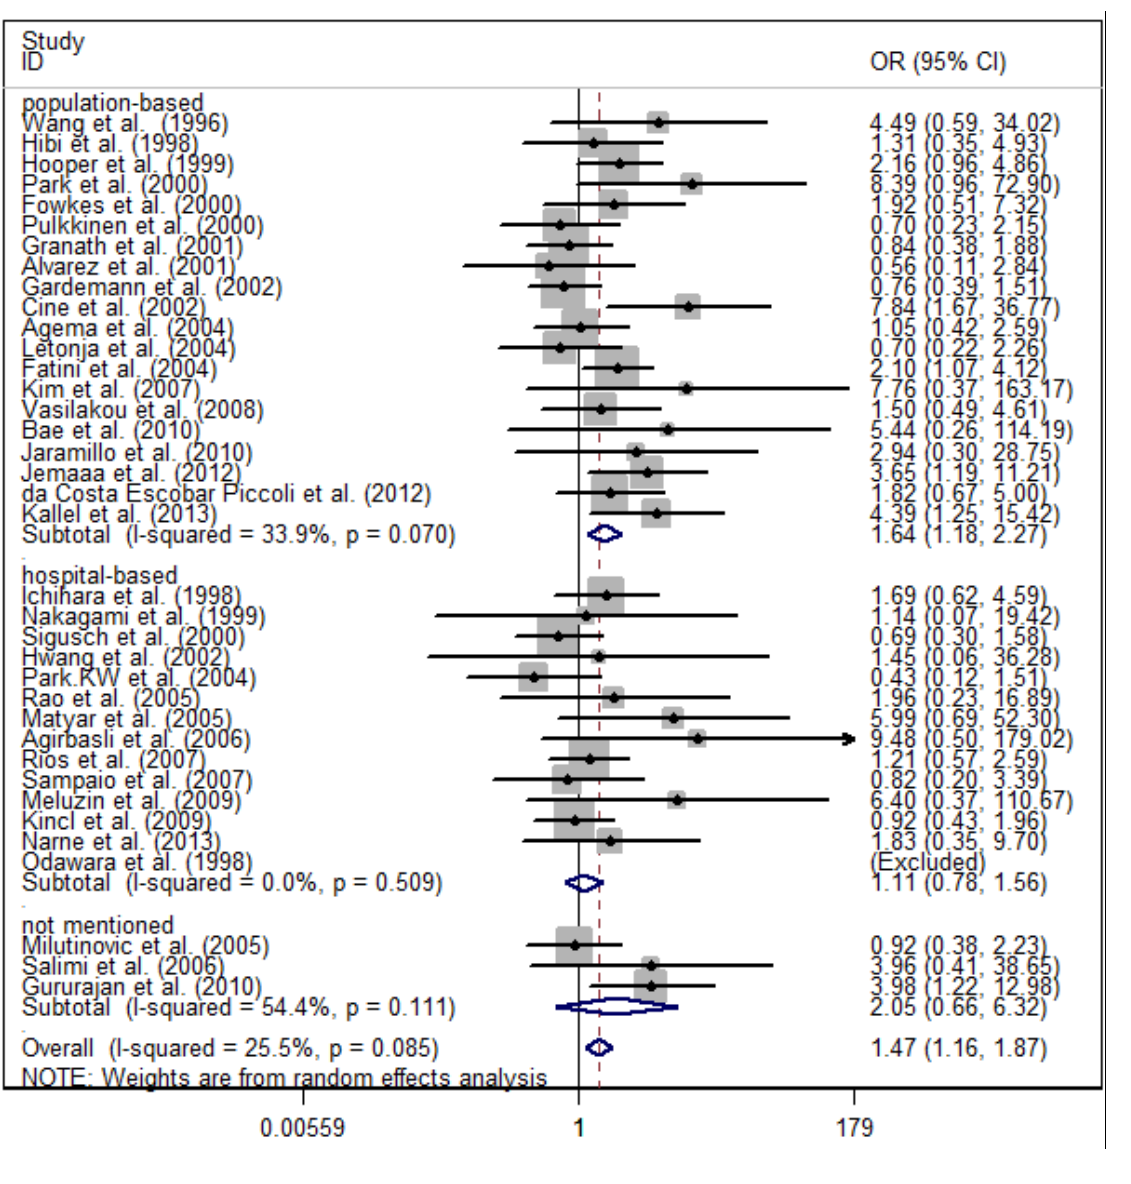
Figure 2. Forest plot of CAD risk associated with the eNOS 4b/a polymorphism by source of control (homozygote